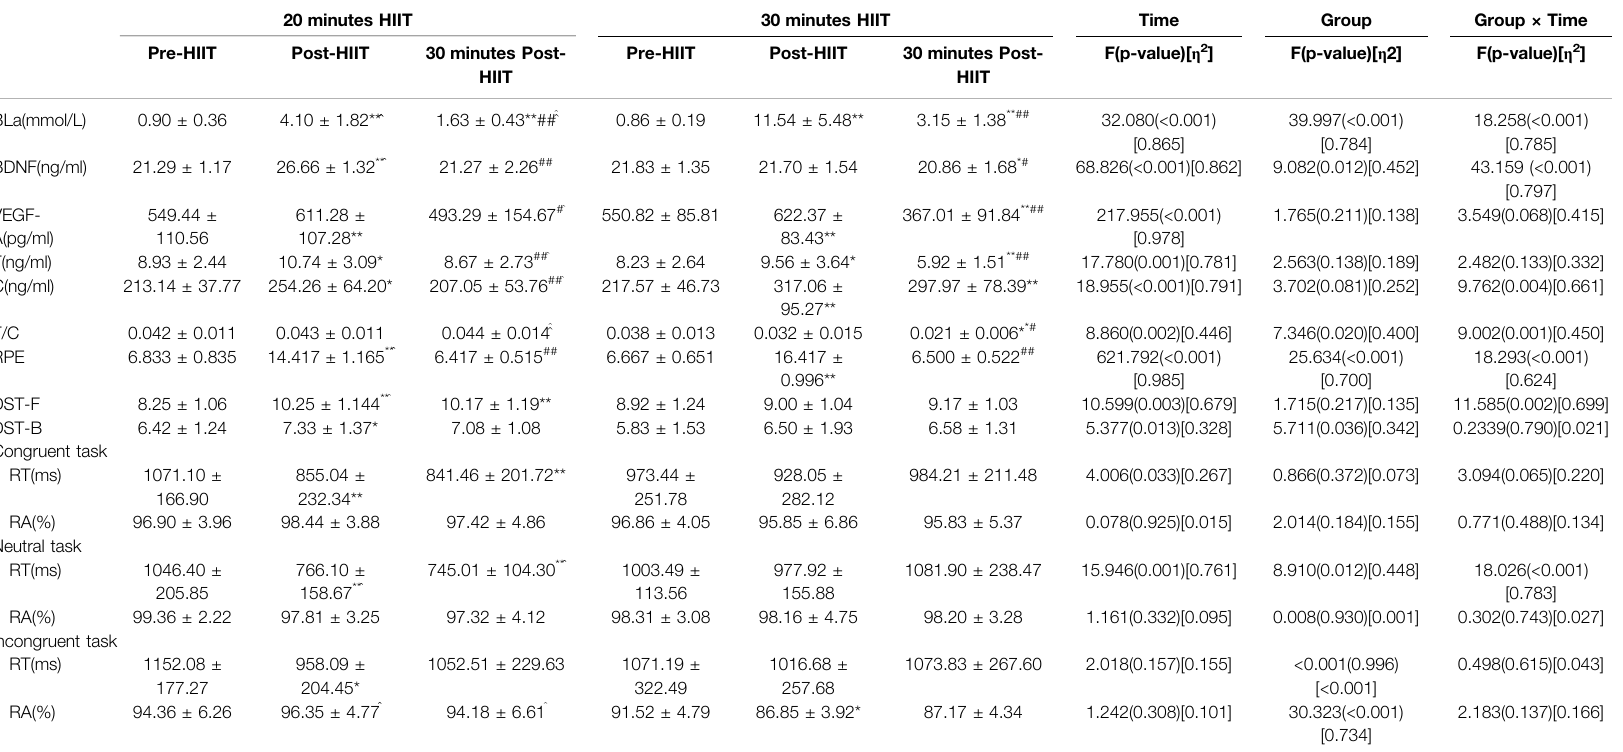
TABLE 2 | Hematology and cognitive function values for subjects in the study (M ±